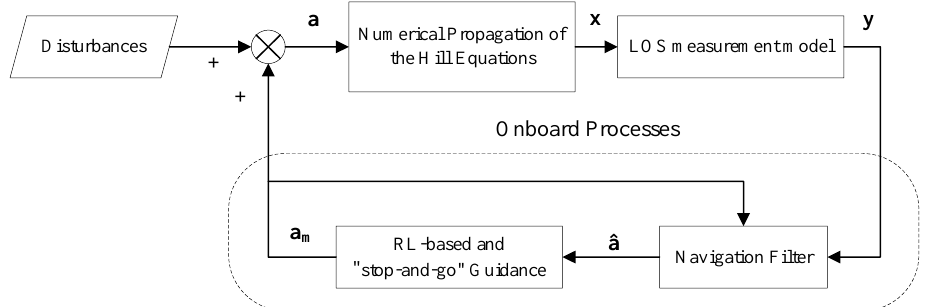
Figure 9. Onboard guidance simulation model.